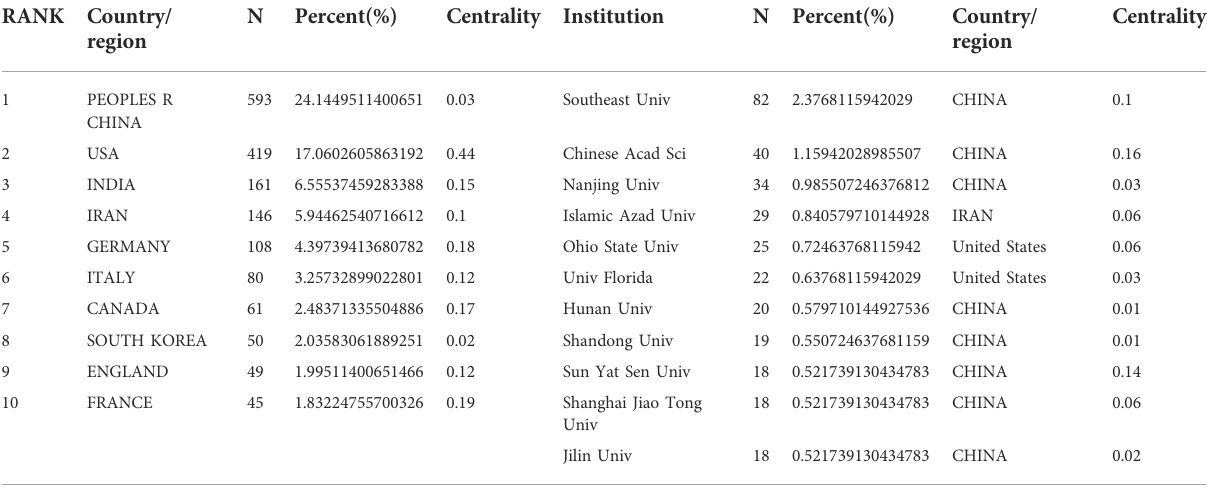
TABLE 3 The top 10 countries/regions and institutions involved in Nanoparticles-leukemia-related research. RANK Country/ region